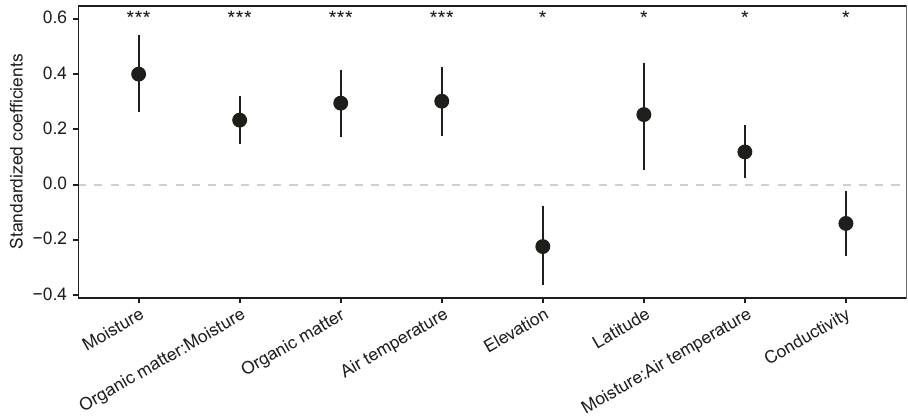
Fig. 4 Resulting coef fi cients from the linear mixed-effects model. Error bars indicate 95% con fi dence interval. Variables are shown in decreasing order of signi fi cance (analysis of variance, *** P < 0.001, * P < 0.05). Moisture, elevation and conductivity have been log 10 -transformed and all variables have been z- transformed prior to analysis. Colons indicate interaction between the respective